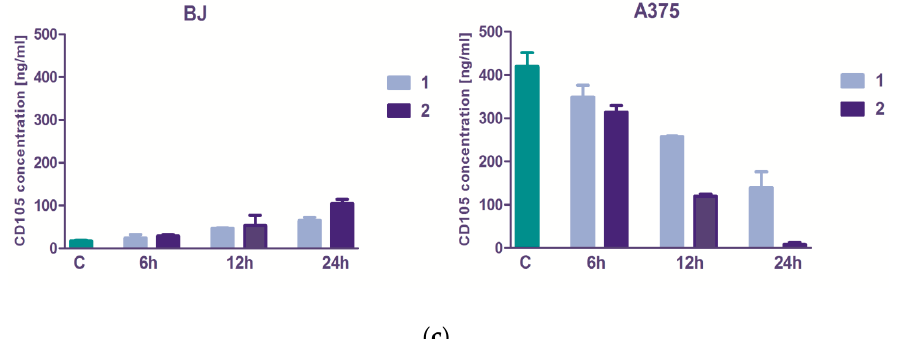
Figure 4. The zeaxanthin-rich extract 1 and 2 influence on CD105 membrane marker expression in normal BJ ( a ) and A375 melanoma cells ( b ). From top down: untreated cells and cells treated for 24 h with 50 µ M extracts 1 or 2 . In the lower row ( c ) the secreted soluble CD105 levels are represented in BJ and A375 cells, following the treatment with 1 or 2 , at the same